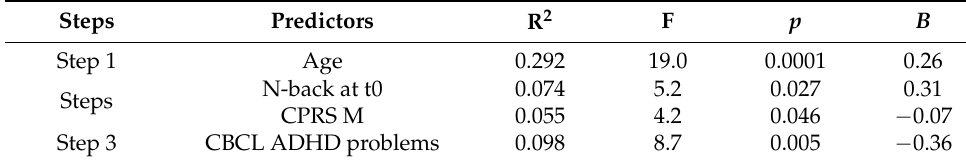
Table 3. Hierarchical linear regression model predicting N-back at t1 after MPH administration.